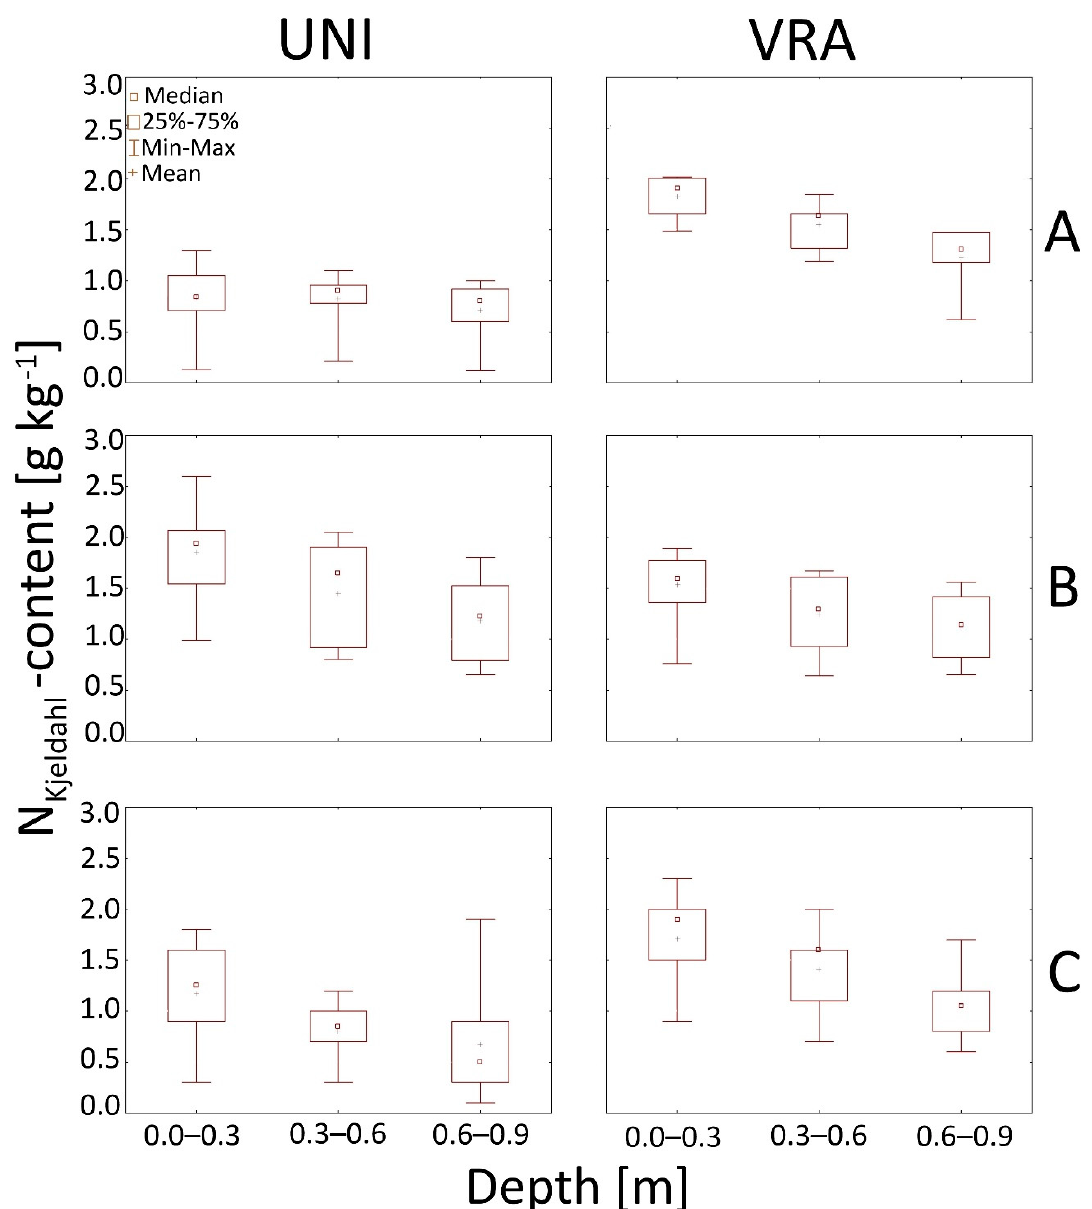
Figure 7. Box and whiskers plots presenting N Kjeldahl content in the soil after uniform UNI and VRA fertilization at analyzed experimental sites A, B, and C. ( A – C ).